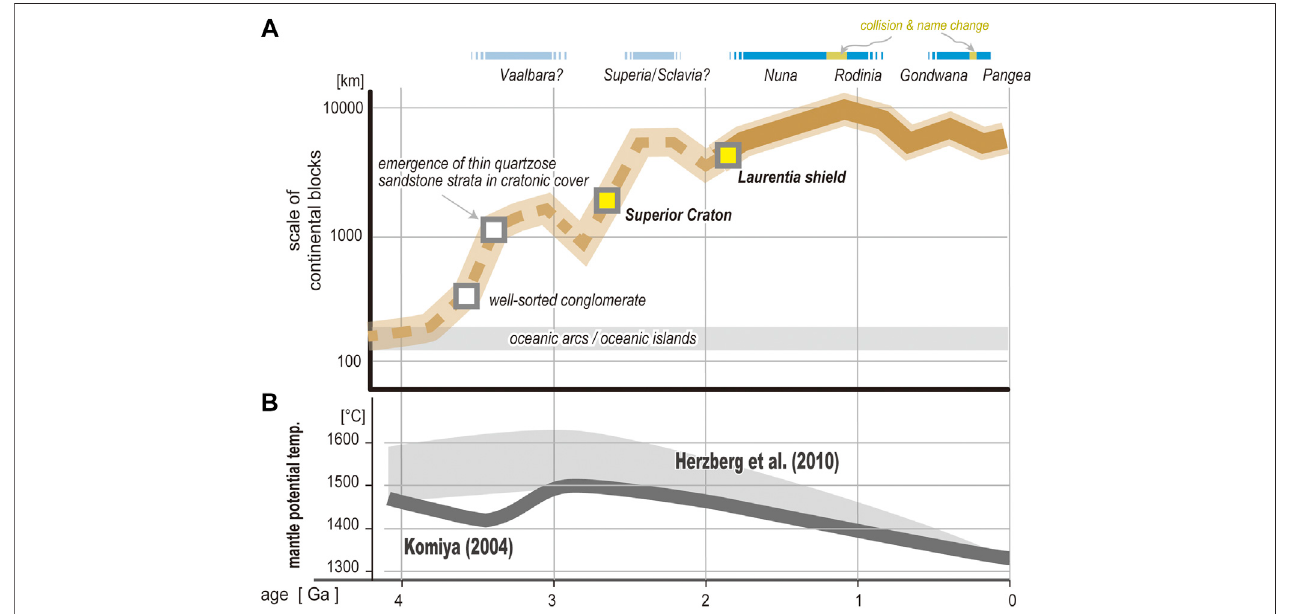
FIGURE4|(A) SchematicdiagramofthemaximumscaleofcontinentalblocksthroughthehistoryofEarthinSupercontinentalperiods(Bradley,2011). (B) Secular trend in the mantle potential temperature estimated through petrological methods (Komiya, 2004; Herzberg et al., 2010).